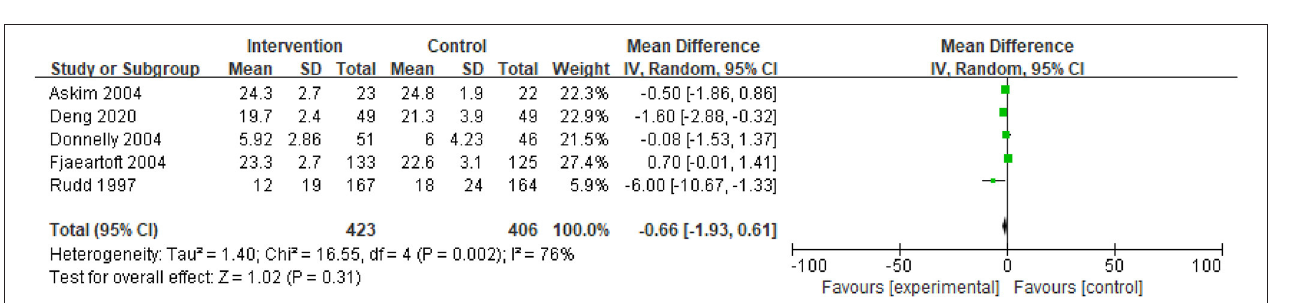
FIGURE 5 | Comparison ESD care vs. usual care; outcome IV: death.